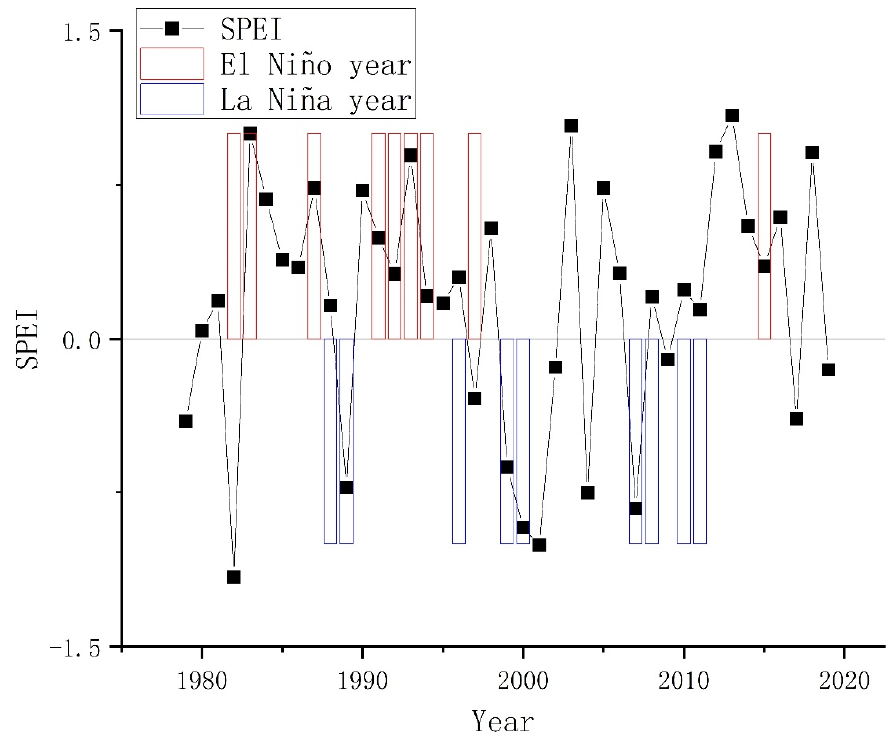
Figure 10. The annual SPEI and El Niño and La Niña years from 1979 to 2019 within the SHRB.